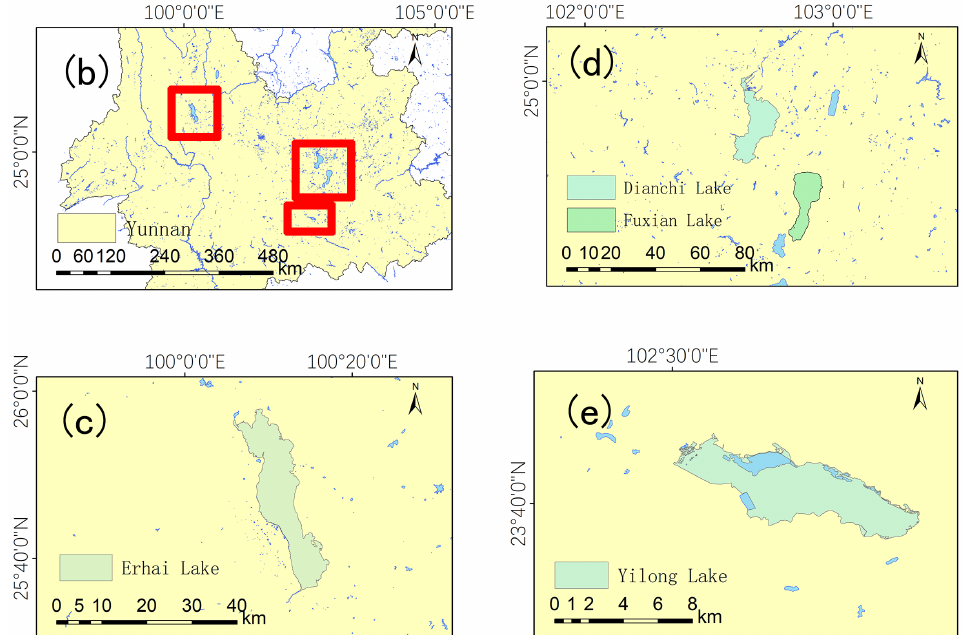
Figure 1. The distribution of the lakes in this study in Yunnan Province, China. ( a ) Distribution map of rivers and lakes in China. The red box indicates Yunnan Province, where the study area is located. ( b ) Distribution map of rivers and lakes in Yunnan Province. Red boxes indicate the four lakes investigated in this study. ( c ) Geographical location of Erhai Lake. ( d ) Geographical location of Dianchi Lake and Fuxian Lake. ( e ) Geographical location of Yilong Lake.